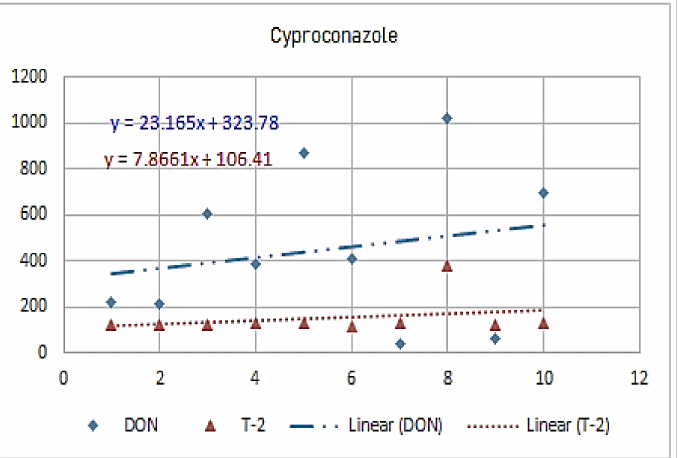
Figure 4. The relation between hyproconazole residue (ppb) and DON and T-2 toxin (ppb) in wheat samples.